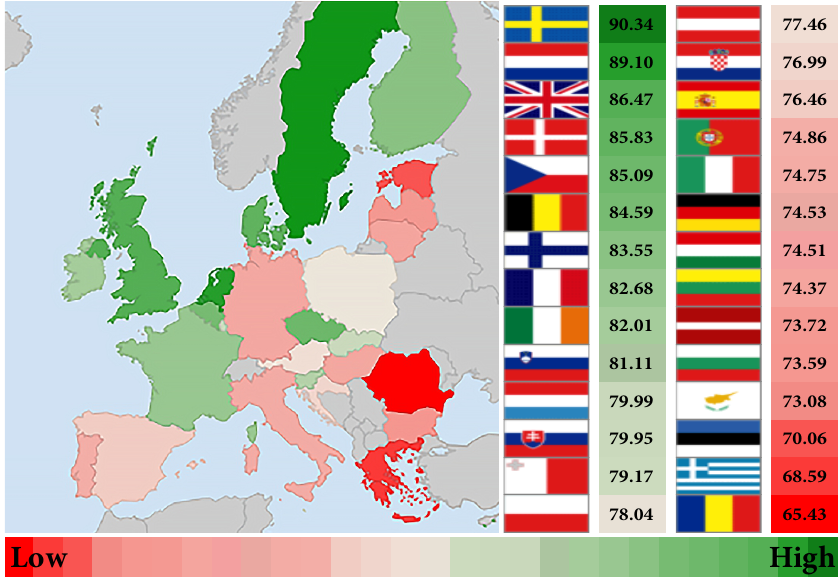
Figure 1. Representation of the Social Inclusion